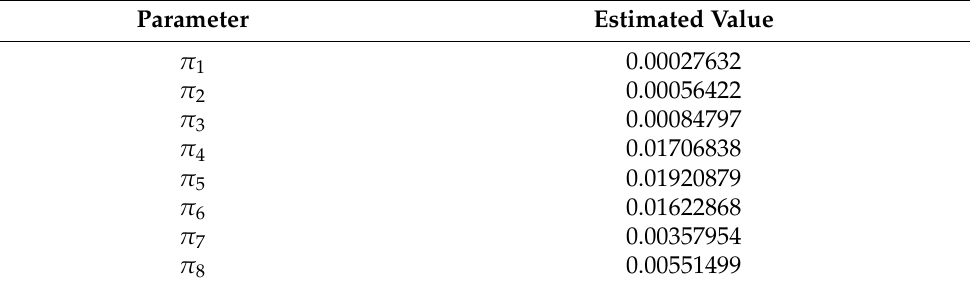
Table A1. Parameters estimation for the 3 DOF